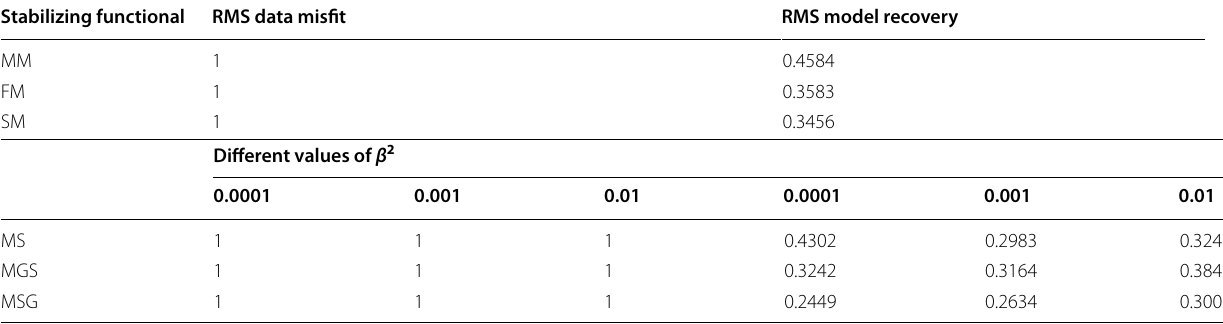
Table 8 RMS data misfit and RMS model recovery of different stabilizing functionals for 2D resistive model Stabilizing functional RMS data misfit RMS model